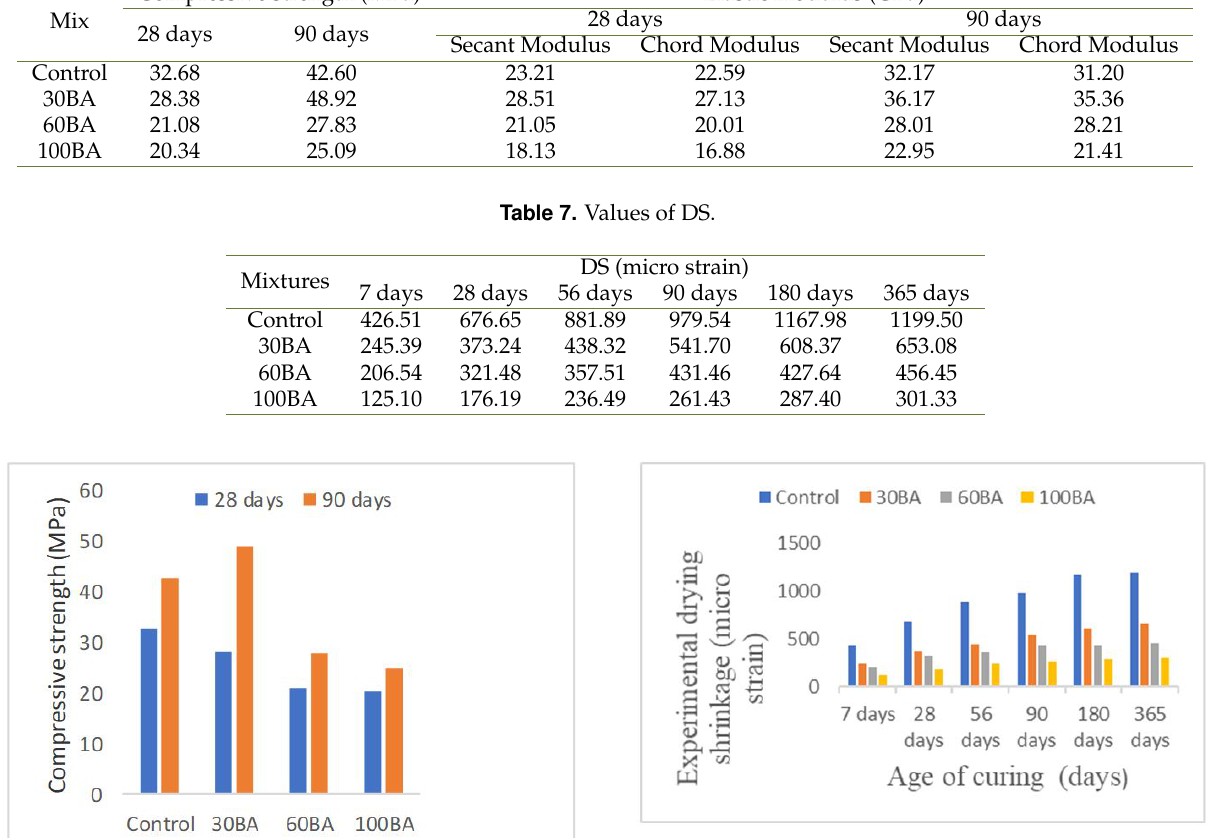
Table 6. Compressive strength and elastic modulus.